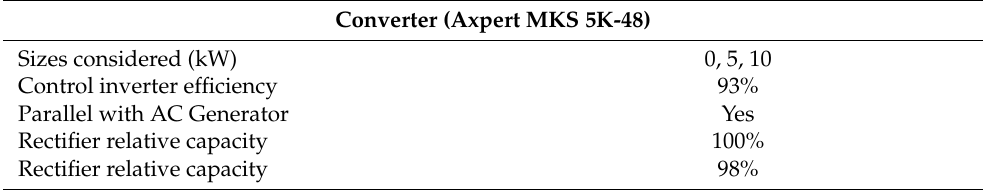
Table 3. The details of Converter model